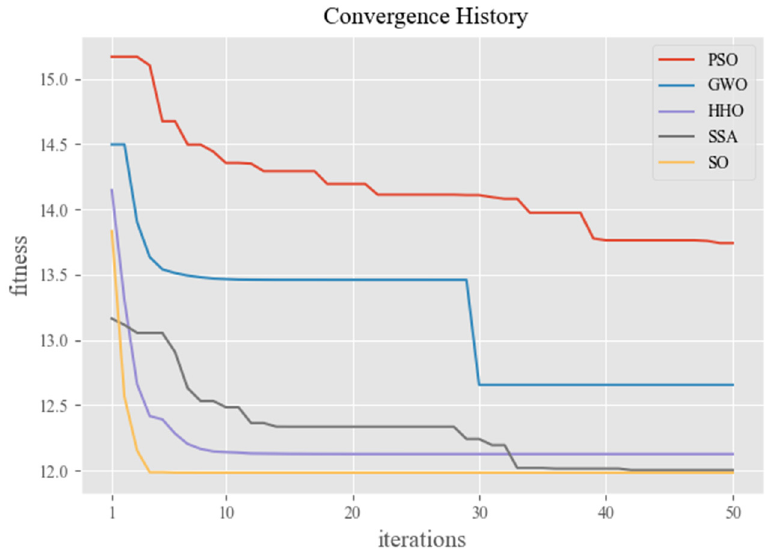
Figure 18. The convergence history comparison of the SSA and other metaheuristics for fit 9 . Table 4. The optimization results of each objective function.